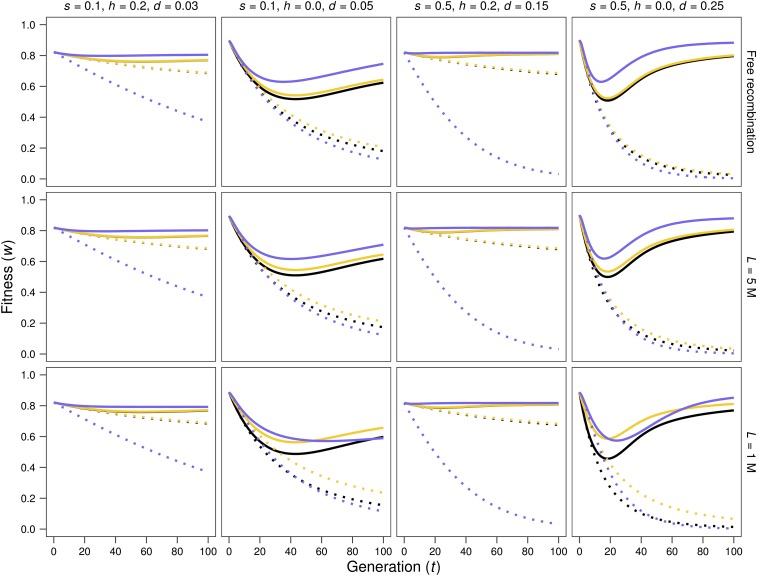
Evolution of average fitness after a reduction of population size to N = 50. Solid lines: MSD results and IP predictions. Dotted lines: MD results and neutral predictions. Blue: average fitness obtained from simulation results; black: average fitness predicted using the inbreeding load of the base population (B); yellow: average fitness predicted using the realized estimate of the inbreeding depression rate δ (see text). Note that these two predictions are on occasion so similar that the black line is completely hidden below the yellow one. Different panels represent different cases regarding the selection coefficient against homozygotes (s), the coefficient of dominance (h), the corresponding d value [d = s(1/2 – h)] and the genome length (L, given in Morgans).